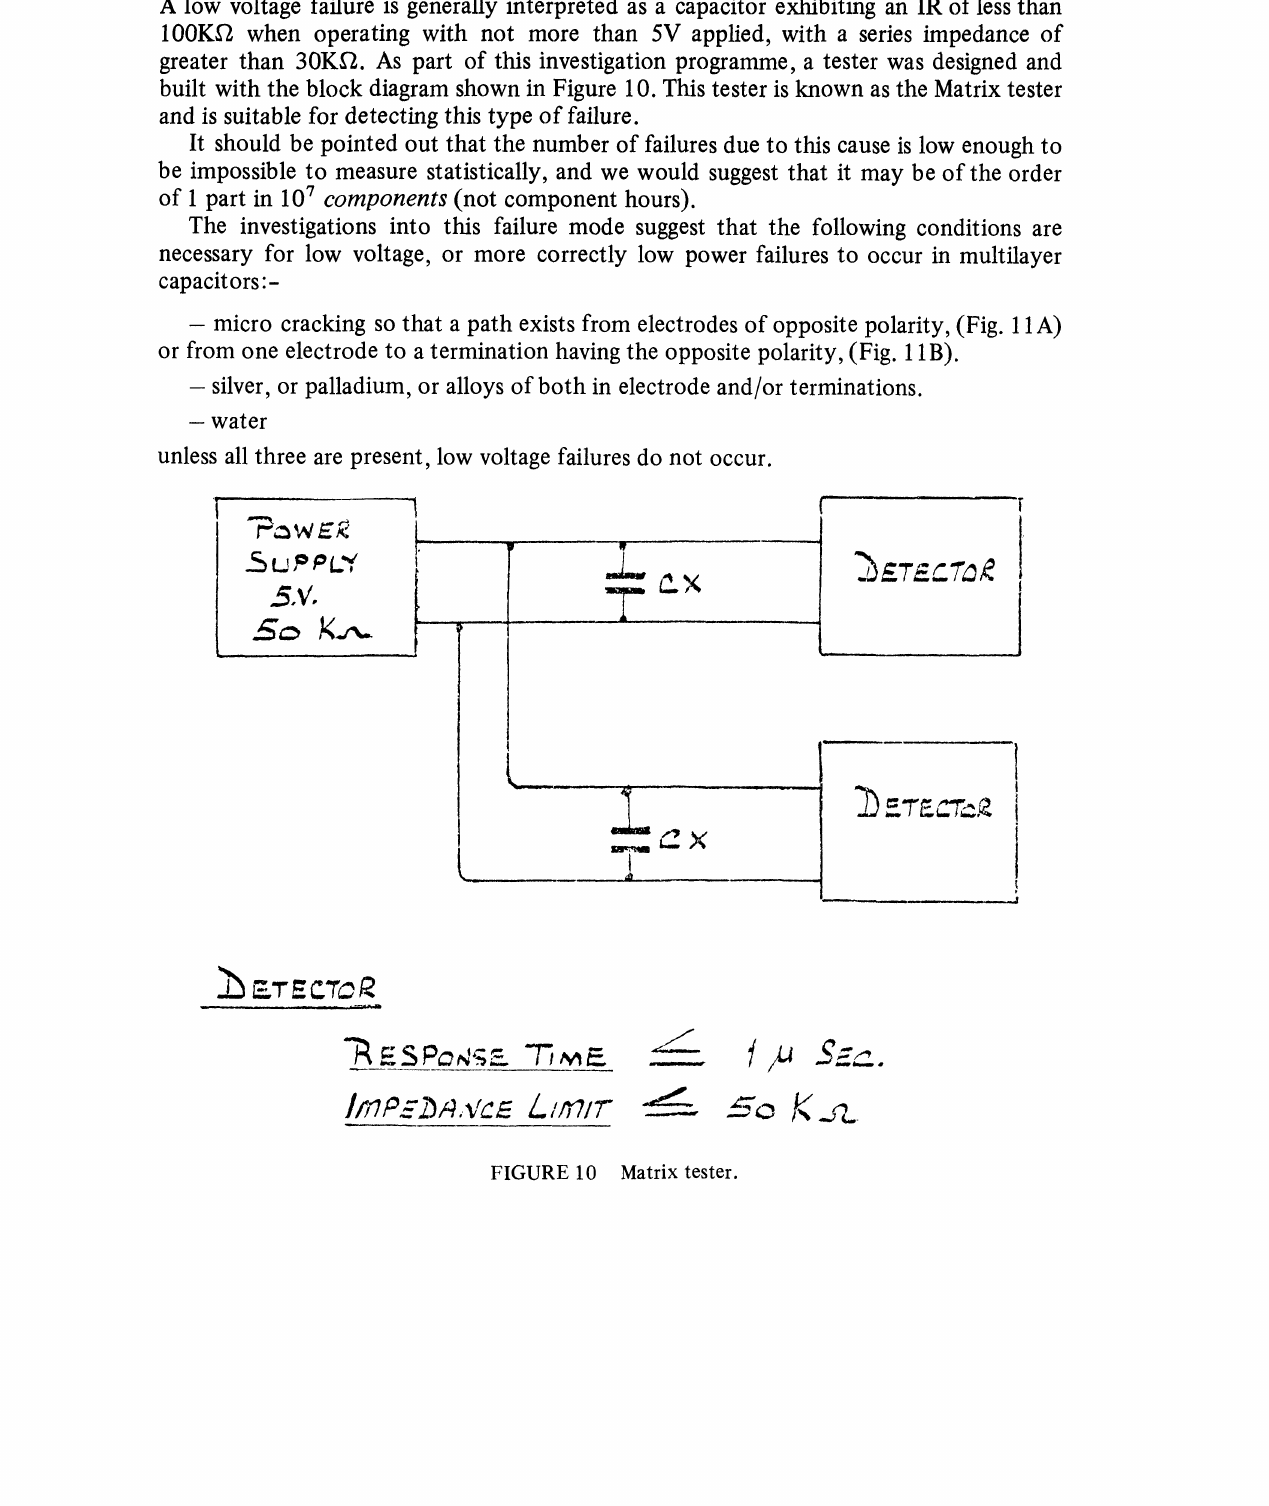
FIGURE 10 Matrix